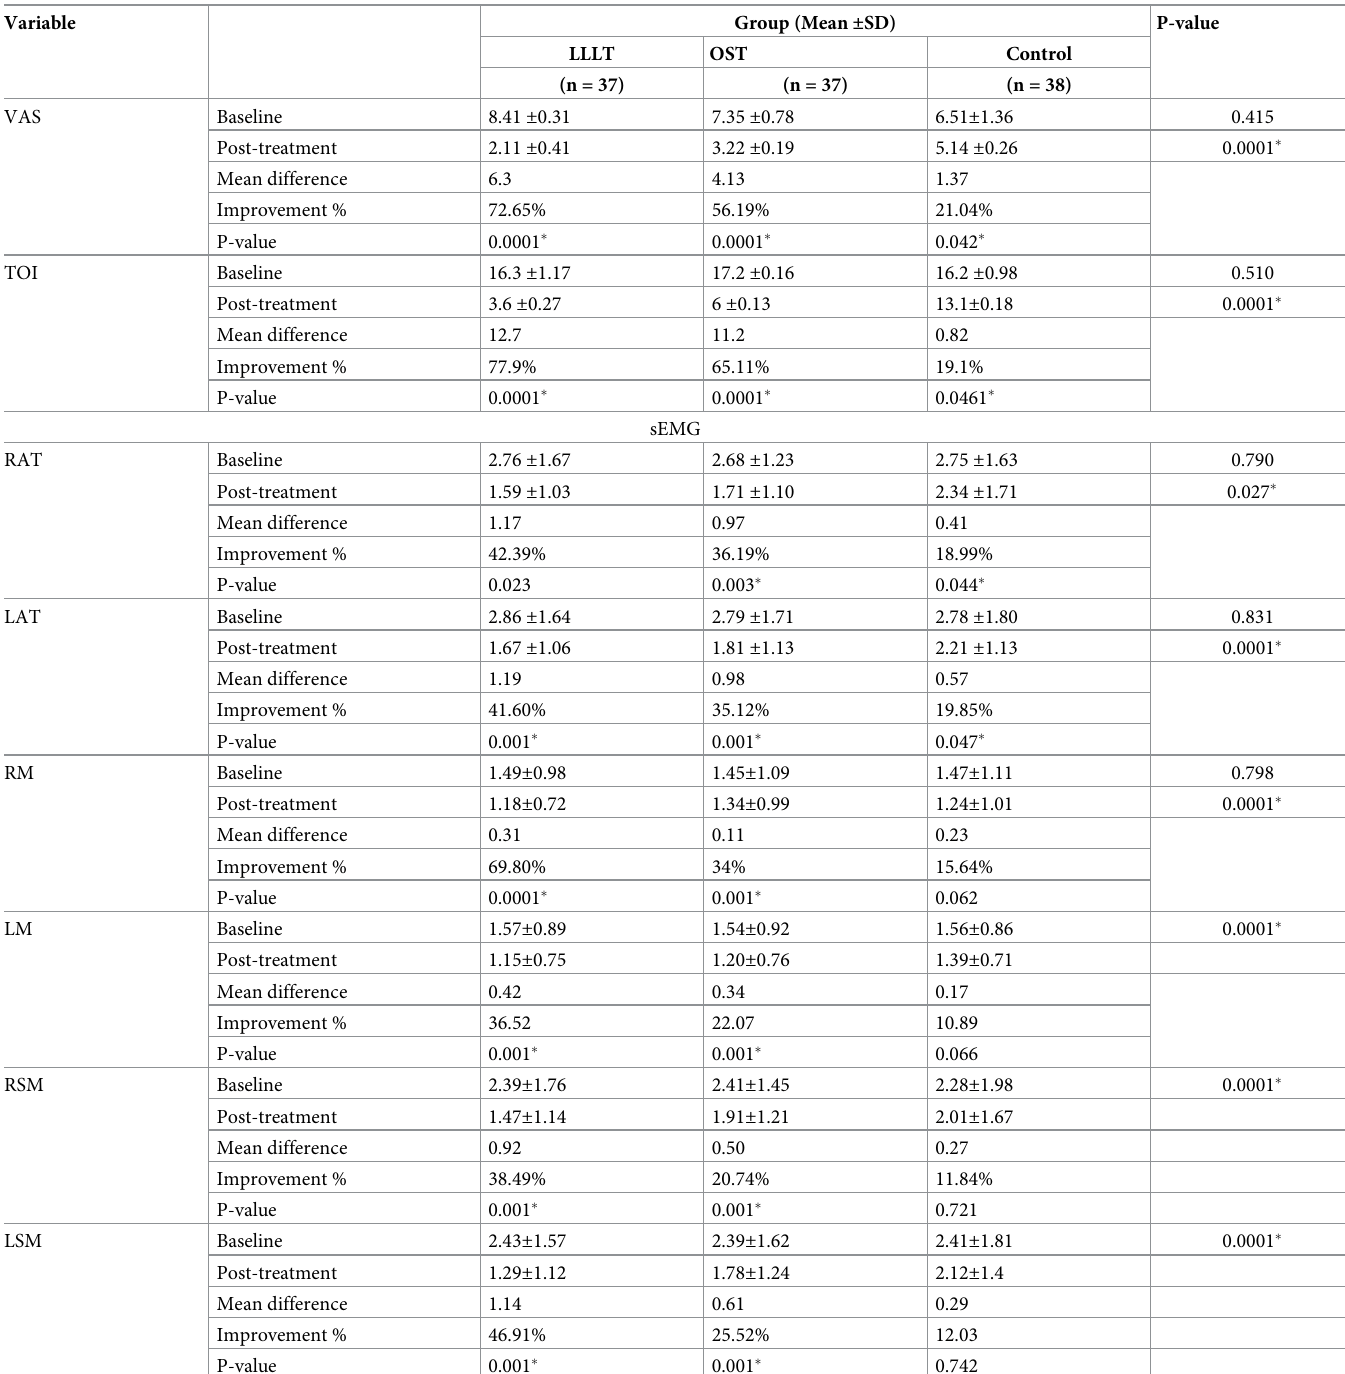
Table 2. Within and between group comparisons (Mixed design MANOVA).